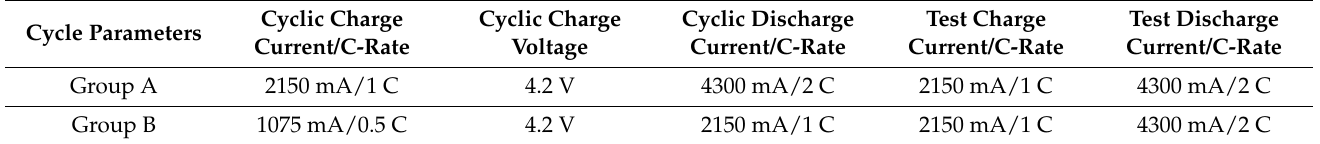
Table 1. Setting of cycle parameters.